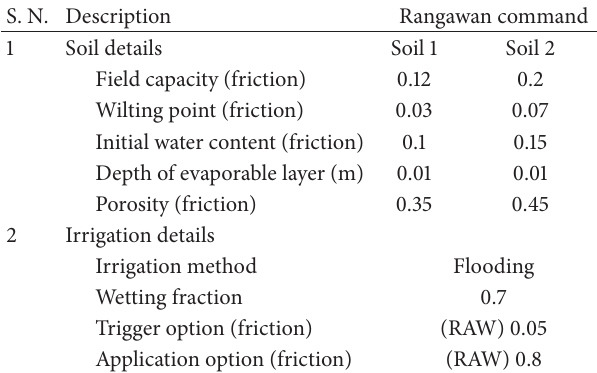
Table3:DetailsofsoilsandirrigationdataforRangawancommand. S. N. Description